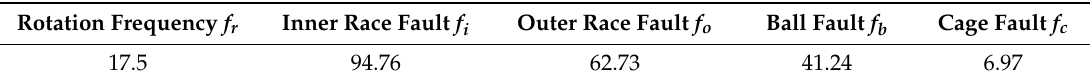
Table 2. Parameters of rolling bearing. Table 3. Defect frequencies of rolling bearing (Hz).